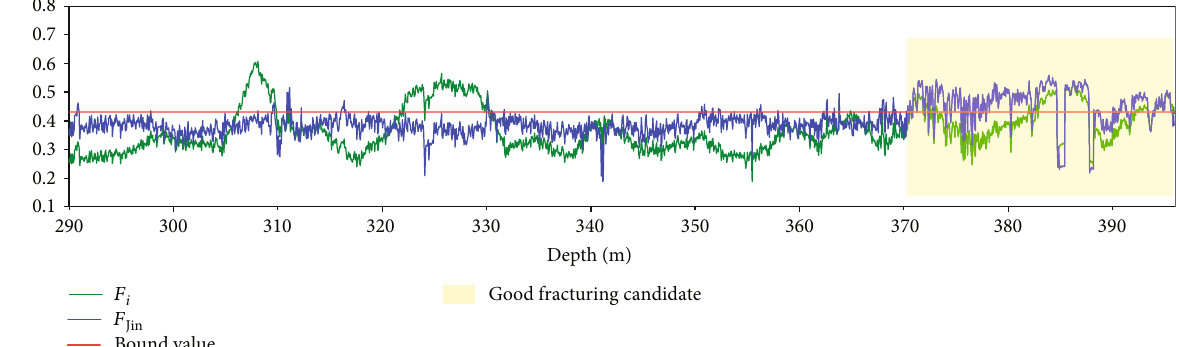
is the fracability index de fi ned by